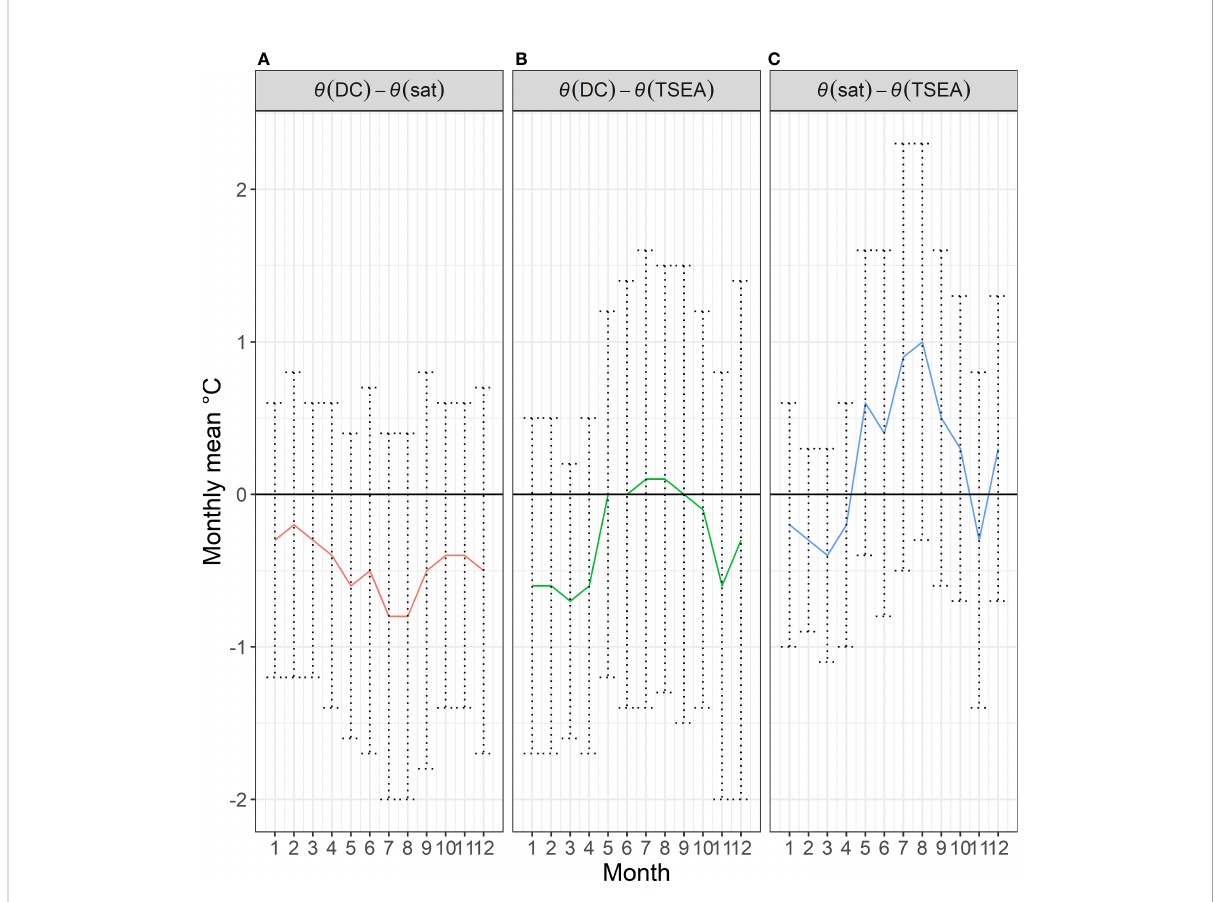
To ascertain the number of dive samples required for consistent results, an approach based on a random fraction of samples per year was used. Analysis was run on random samples of different sample fractions (75, 50, 25, 10 and 1%).